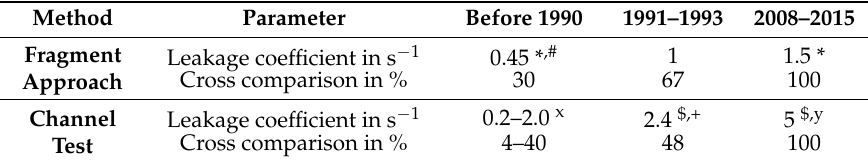
Table 1. Temporal increase in leakage coefficient (in 10 − 6 s − 1 ) at transect II, WW